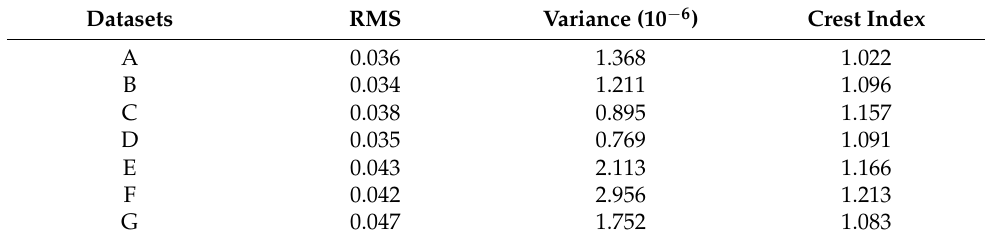
Table 7. The statistical results of the other parameters.